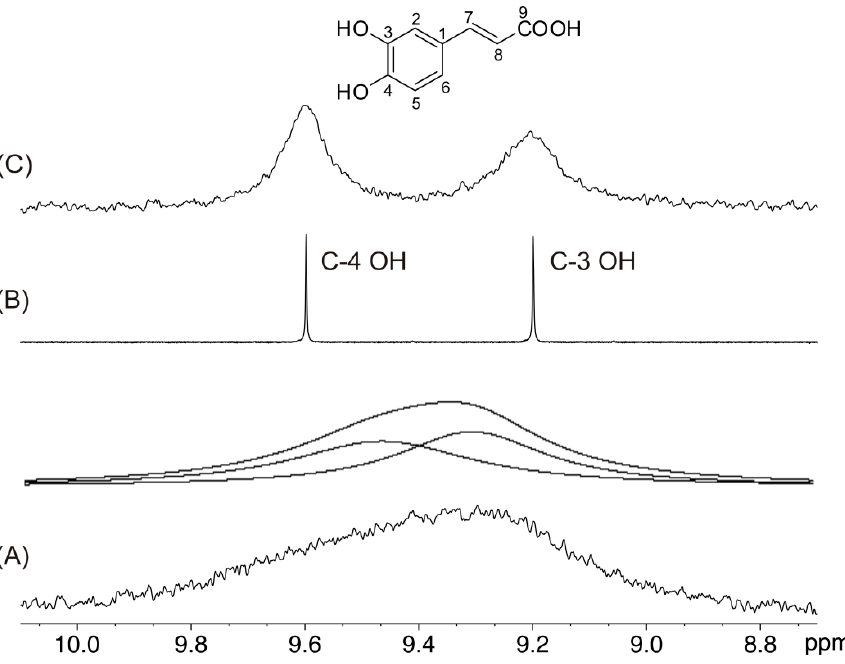
Figure 2. 500 MHz 1D 1 H-NMR spectra of the hydroxyl group region of caffeic acid (1) (C = 5.7 × 10 − 3 M, T = 292 K, number of scans = 32), in ( A ) DMSO- d simulated line-shapes with two Lorentzian peaks for C-4 OH and C-3 OH having line-widths of 203 Hz and 164 Hz, respectively, using the Bruker peak-fitting routine; ( B ) and ( C ) with a molar ratio [picric acid]/[caffeic acid] of 12 × 10 − 3 and 219 × 10 − 3 , respectively. Reproduced with permission from [16]. Copyright 2001, by the